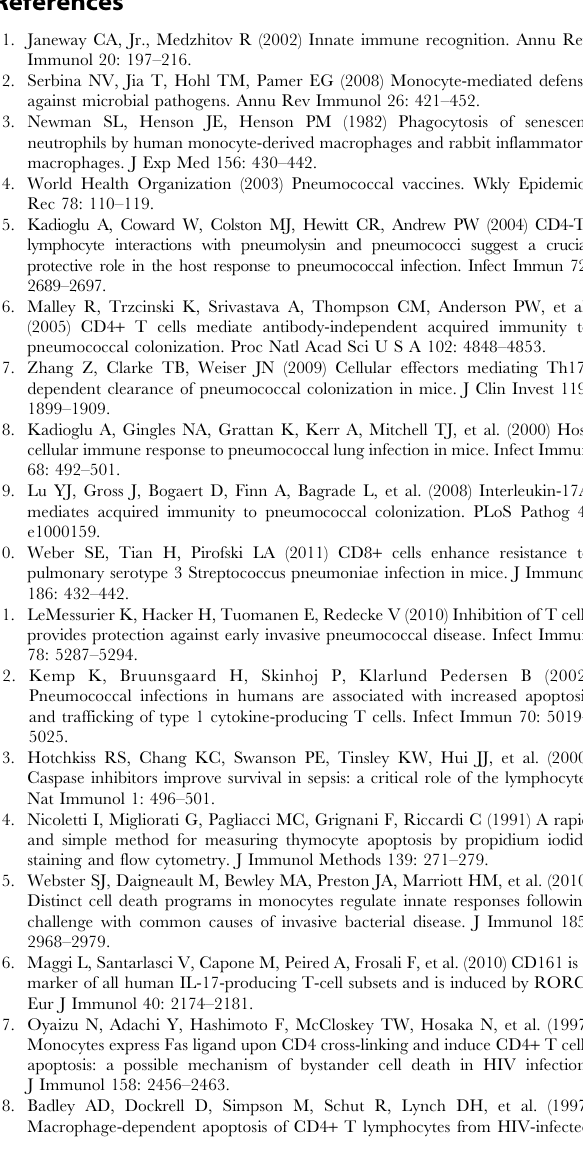
Figure S9 Characterization of hypodiploid DNA. Periph- eral blood mononuclear cells (PBMCs) were mock-infected (MI) or infected with serotype 2 Streptococcus pneumoniae (D39), or serotype 1 strains with (INV104B) or without (NCTC7465) endonuclease A activity, at multiplicity of infection (MOI)= 50. Some NCTC7465 cultures were also incubated with DNase ( + DNase). Six hours conjugated anti-CD3. The percentage of sub G0/1 CD3 + T-cells was identified using propidium iodide (PI) staining. A) Represen- tative dot plots showing gating of the PBMC population using